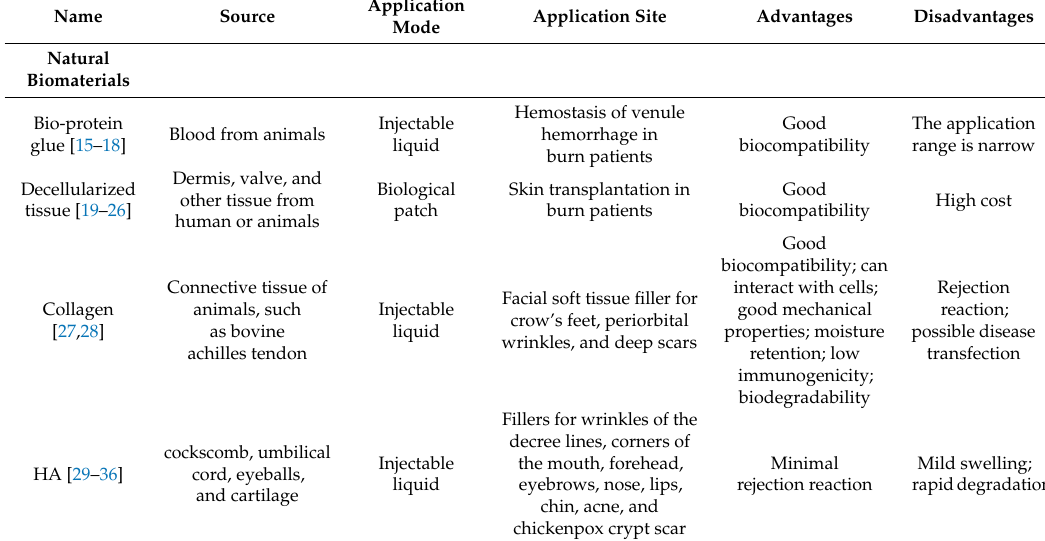
Table 1. Overview of natural biomaterials related to plastic